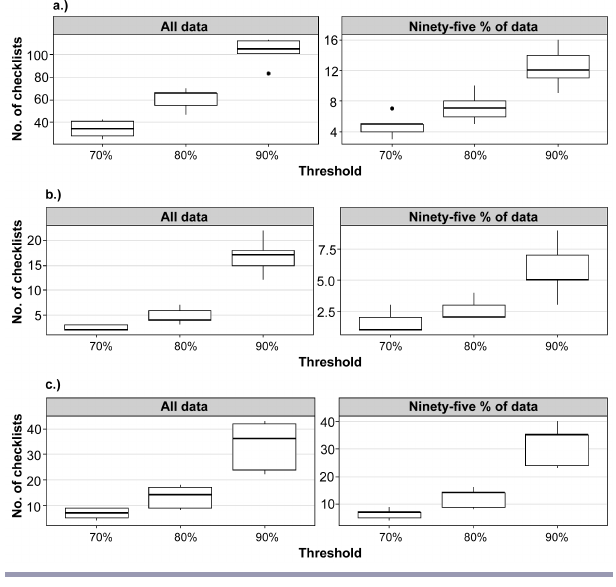
Fig. 3 . The number of checklists (2010–2016), necessary to meet 70%, 80%, and 90% thresholds for 5 global sites (Table A1.2) for (a) species richness, (b) Shannon diversity, and (c) community composition (Bray-Curtis similarity). Separate analyses are provided for the full dataset, and for those species recorded on > 5% of all checklists at the site.